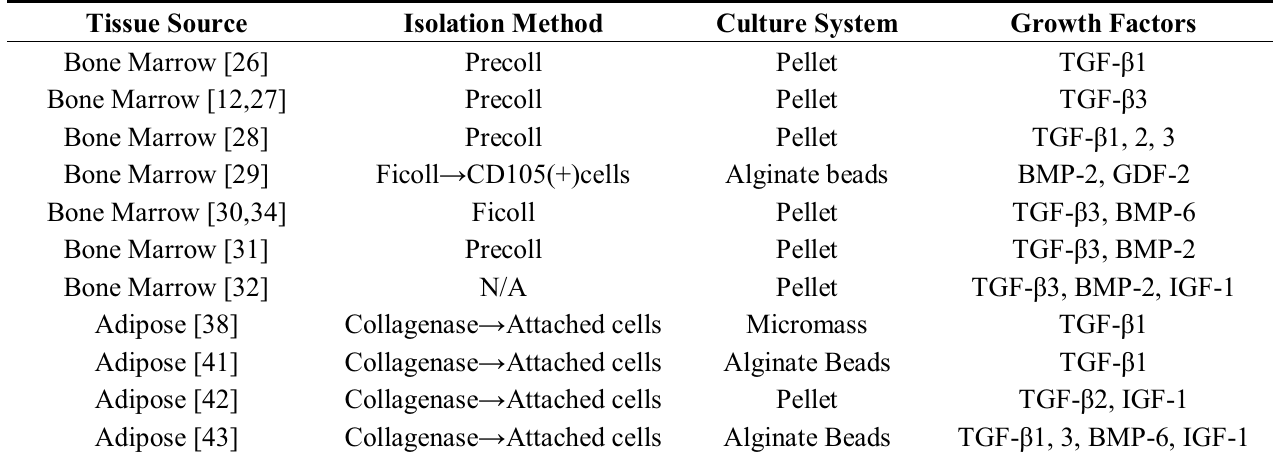
Table1. In vitro chondrogenesis using adult human stem